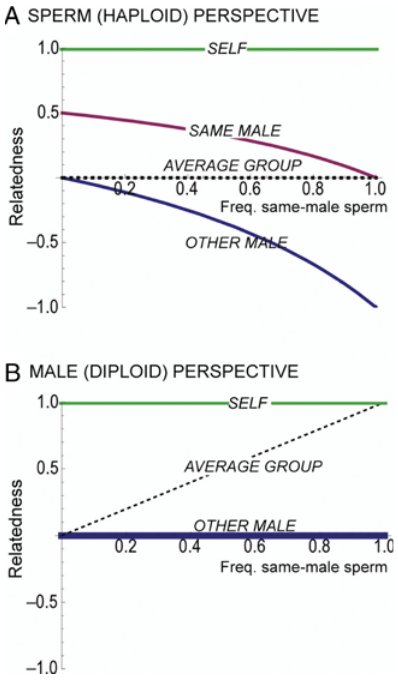
Figure 1. Genetic Relatedness among Sperm and Males as a Function of Female Re-Mating Rate (Risk of Sperm Competition) Social evolution theory predicts that relatedness is central to social behaviour. When two individuals share more genes in common than the population average, they are genetically related, and natural selection can favour altruistic behaviours that invest in another’s reproduction, as with social insect workers. Formally, relatedness is calculated as ( p p )/( p − p ) where p , p , and p denote focal gene frequency in recipients, A R A actors, and the population (Box 1, [42]). Calculations of relatedness require one to assign the relevant population scale at which individuals interact and compete (see Box 1, [16]). And, importantly, we are